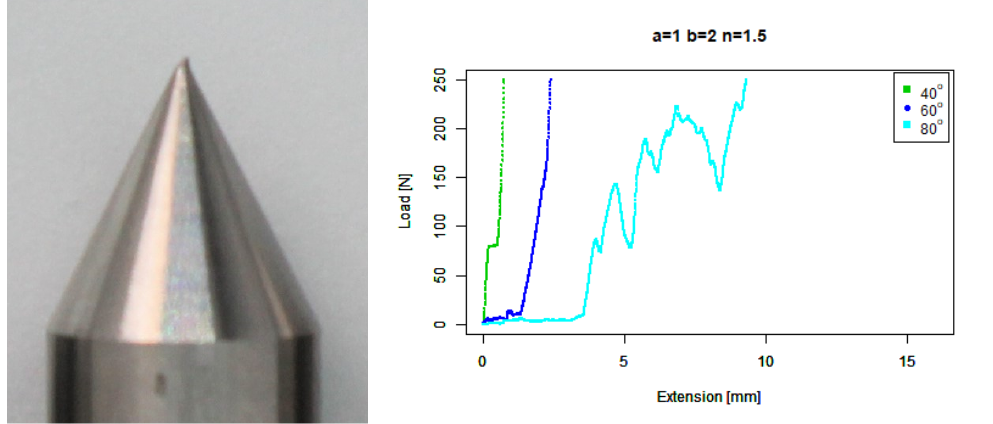
Figure 10. Extruded angle tip. ( Left ) Tip Profile. ( Right ) Experimental